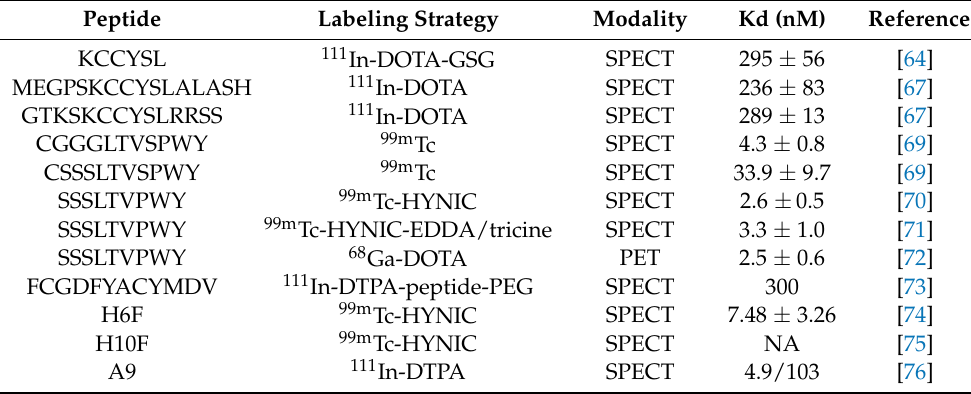
Table 5. Specific HER2-targeted